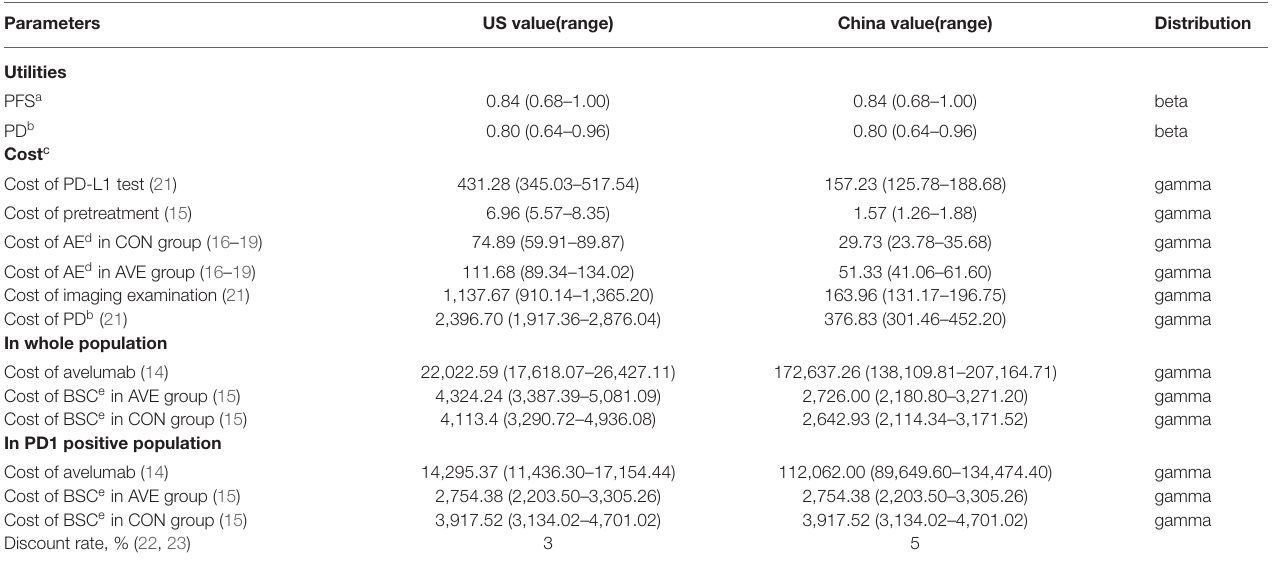
TABLE 1 | Input parameters for cost-effectiveness analysis.